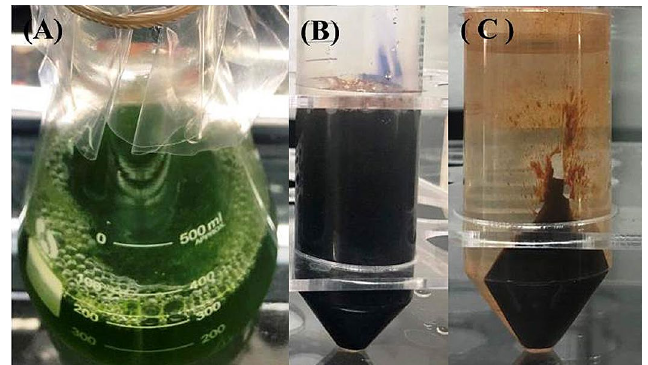
Figure 1. One month old Chlorella K01 culture ( A ) and synthesized Fe 3 O 4 -NPs solution ( B ), Crude Fe 3 O 4 -NPs ( C ).